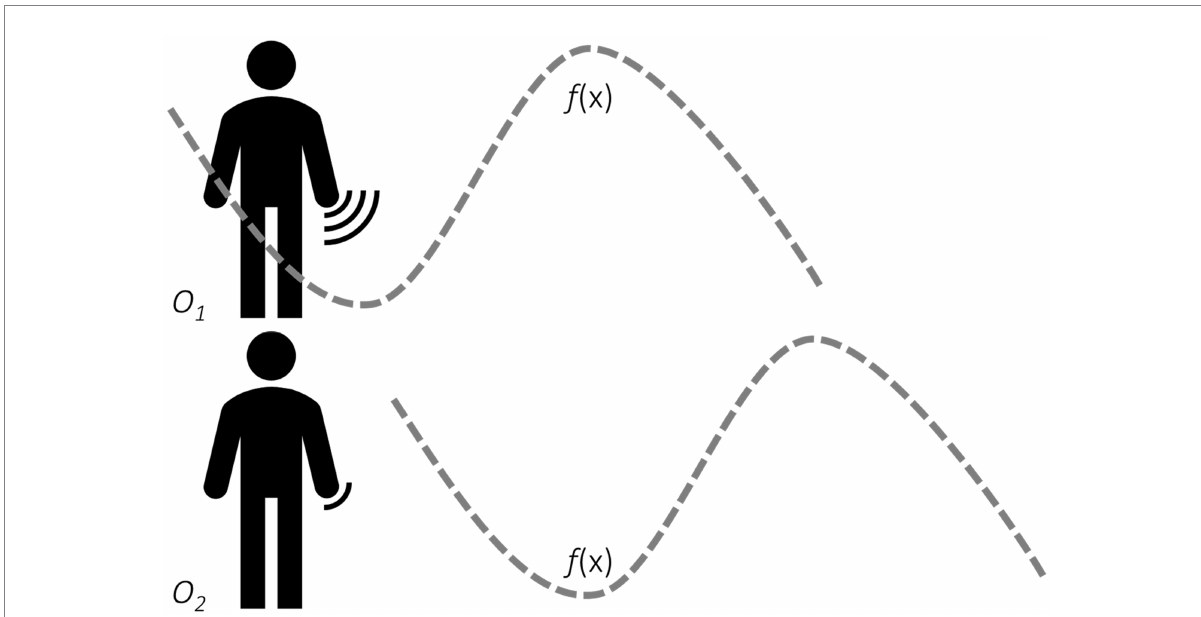
FIGURE 1 Illustration of the role of hand gestures for the understanding of mathematical concepts. f (x) stands for a mathematical function (e.g., sin (x) ) that is amenable to visualization (in this case, a 2D Cartesian representation). O 1 represents an active observer (character’s viewpoint), and O 2 represents a passive observer (observer’s viewpoint). The interface icon by the hand of O 1 and O 2 illustrates the strength of ‘embodied resonance’ elicited in each scenario. O 1 has a stronger degree of engagement with the graph and imagination of the graph rather than seeing the graph (as it is the case with O 2 )